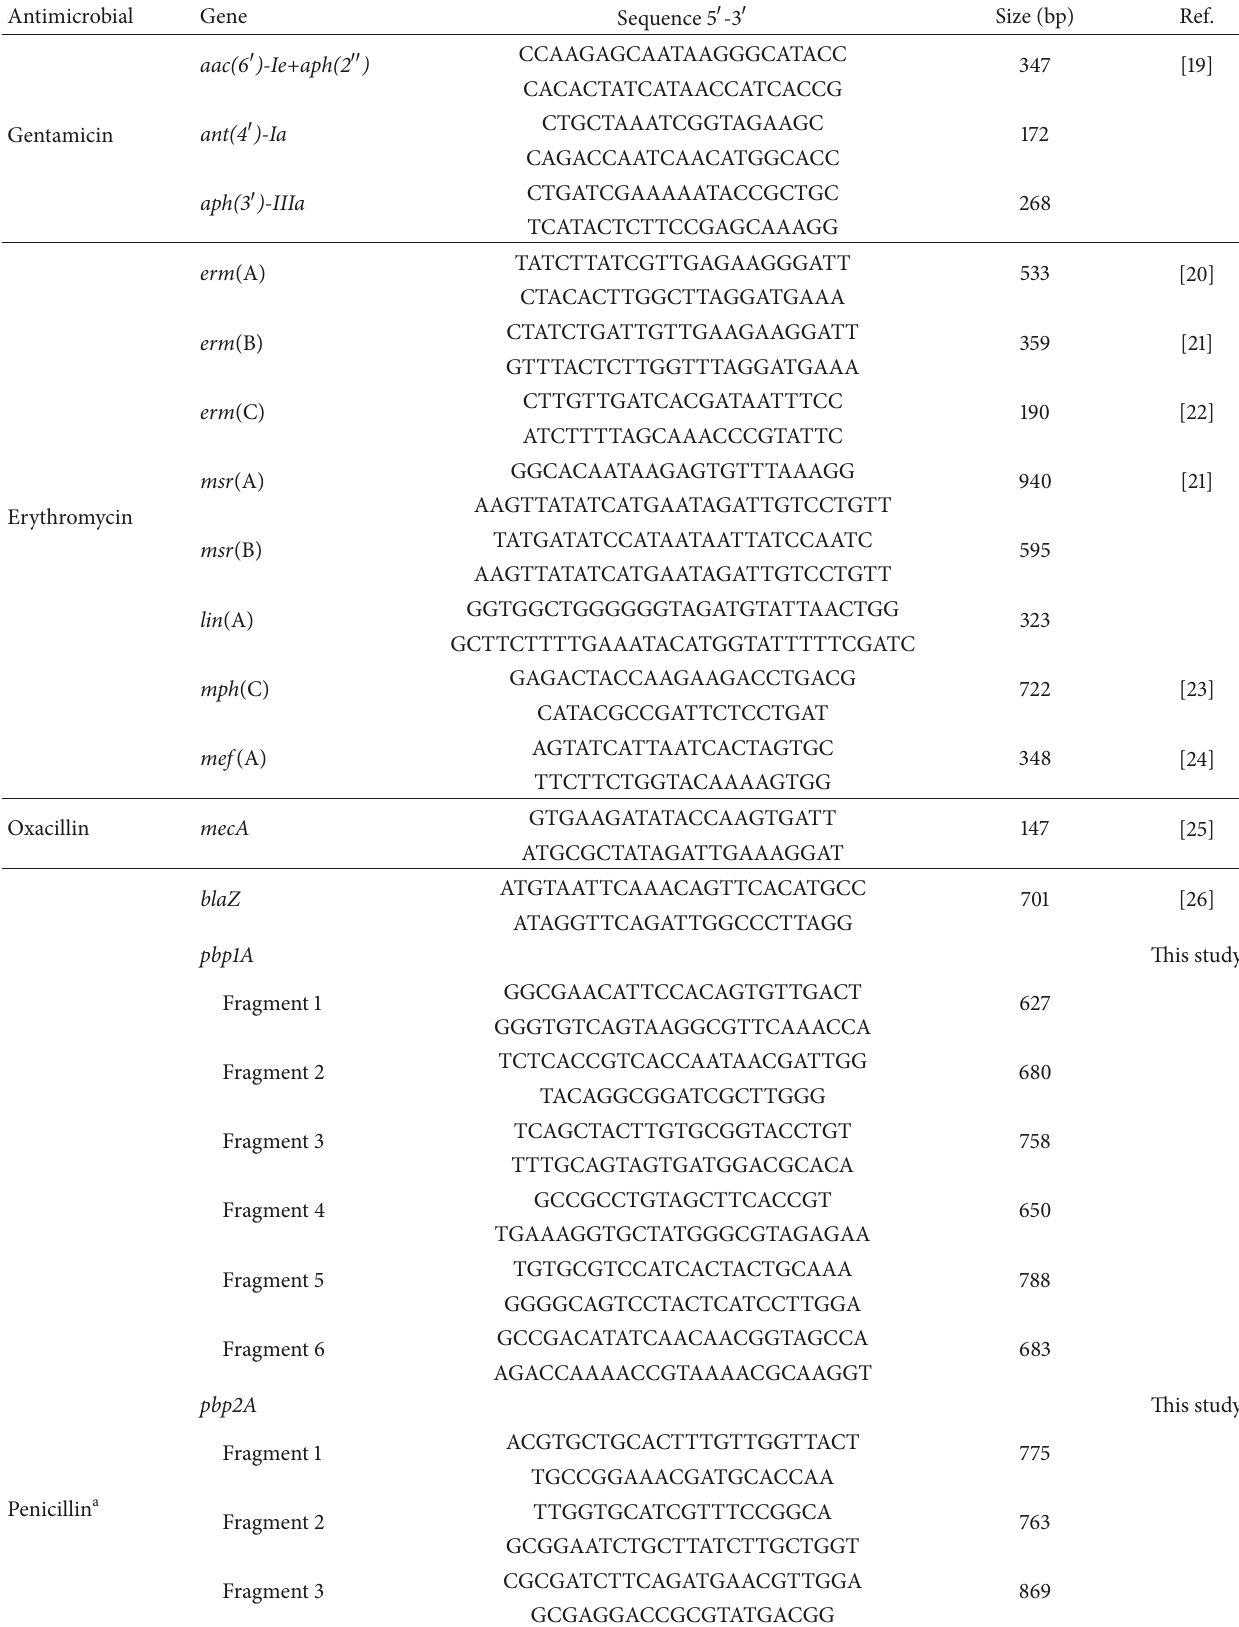
Table 1: Primers used for screening of resistance determinants in Staphylococcus saprophyticus .